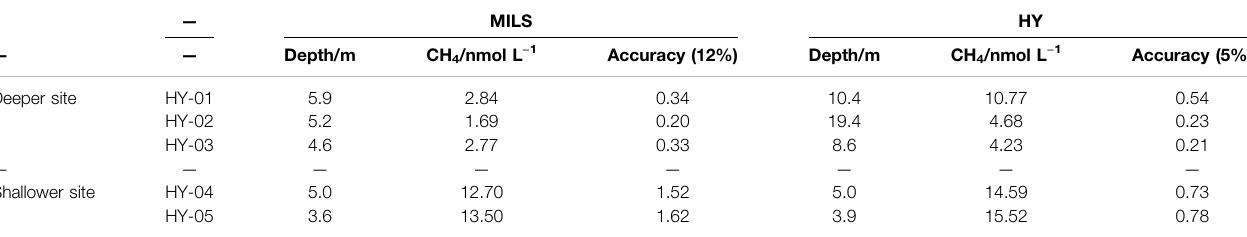
TABLE1| Datausedin Figure6 forthedeeperandshallowersite.MILS(Membraneinletlaserspectrometer)dataareanaveragefrommeasurementswhichwereclosestto the discrete water sampling (HY) locations. HY data are averages between the PT and HS analysis. Water depths and estimated accuracies of the measurements are also reported.